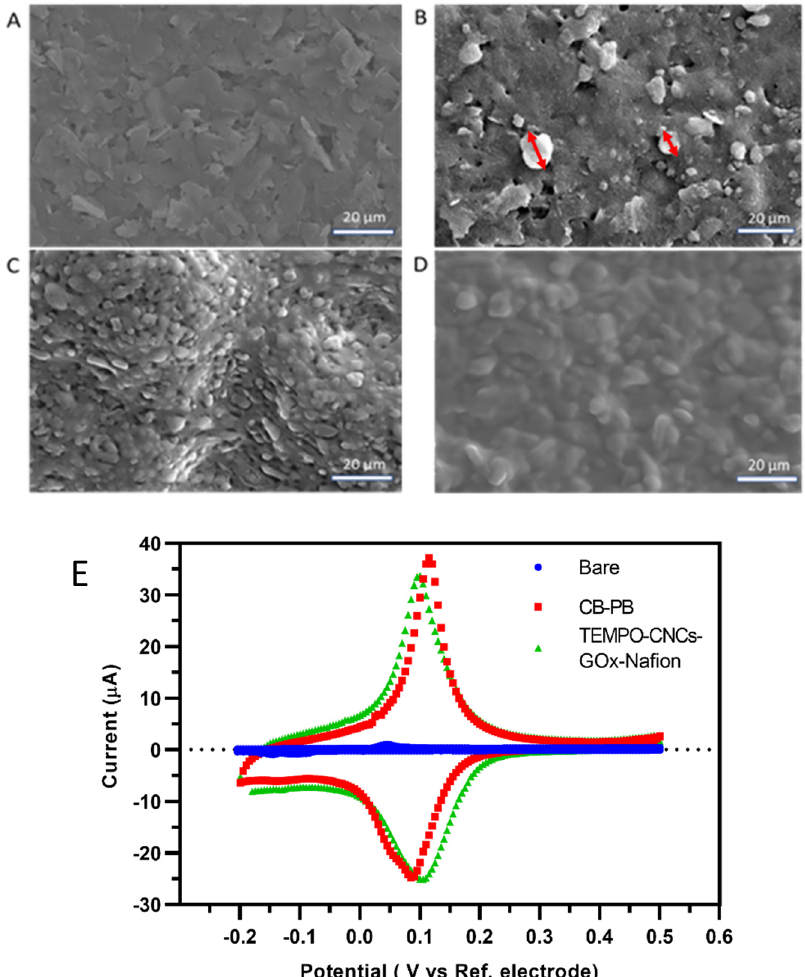
Figure 3. ( A ) SEM image of the bare SPE. ( B ) SEM image of the carbon black–Prussian blue (CB–PB) layer. White arrows exemplarily mark CB microparticles and white triangles exemplarily mark PB nanoparticles. ( C ) SEM image of the TEMPO-CNC-GOx layer. ( D ) SEM image of the Nafion layer. ( E ) Cyclic voltammetry of the TEMPO-CNC glucose sensor after different modification steps: bare (blue dots), after CB–PB modification (red squares), and after TEMPO-CNC-GOx and Nafion modification (green triangles) in phosphate buffer.